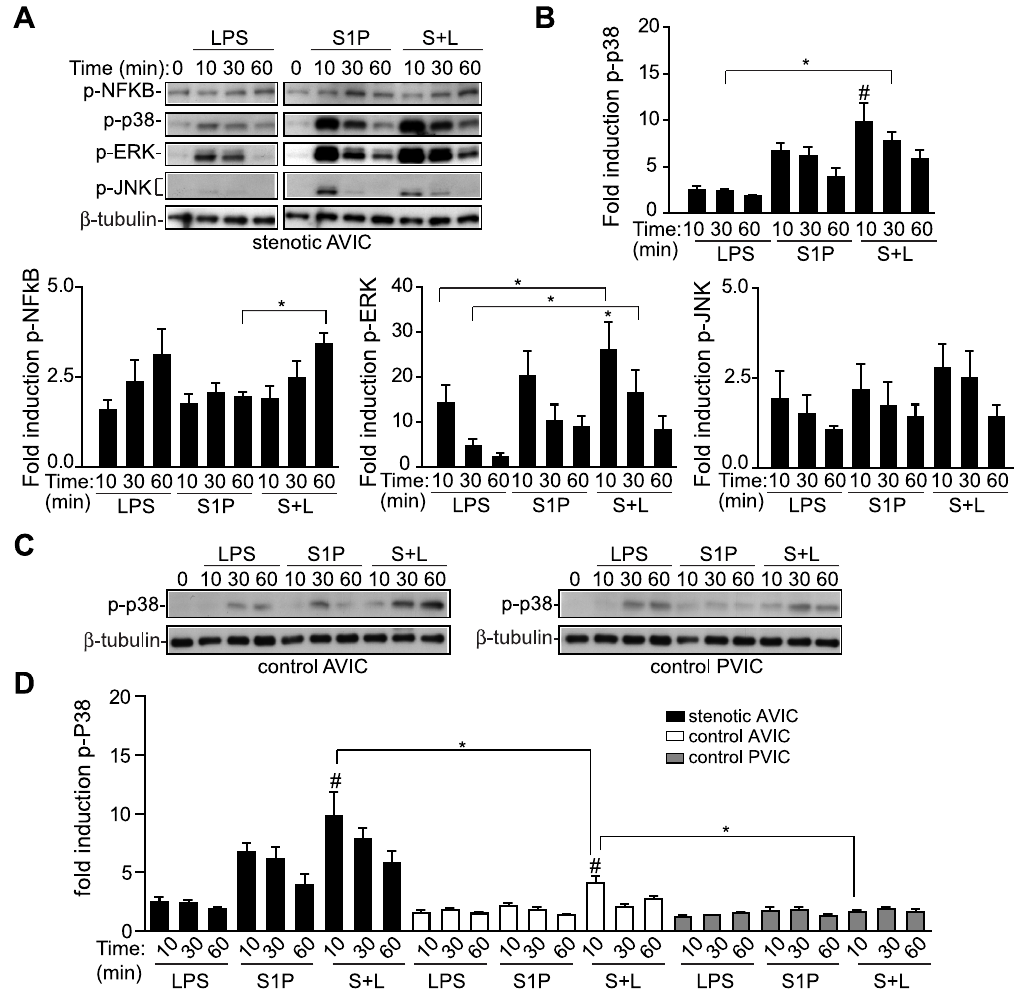
Figure 5. Several signaling cascades, mainly p38/MAPK, are involved in the cooperative effect. A–B) Cell lysates from activated stenotic AVIC were analyzed for the early phosphorylation of NF- k B and MAP kinases. Representative immunoblots and densitometry data show synergistic activation of p38 by S1P + LPS (n=6). Sample at t=0 was run in both gels for comparison purposes. C) Representative immunoblots of p38 phosphorylation in AVIC and PVIC from the same patient processed in parallel are shown. D) Densitometry data is expressed as the fold induction of p-p38 relative to resting values (t=0) using data previously normalized to the reference gene, b -tubulin (mean 6 SEM, n=5–7). Color bars, as in Figure 2. * p , 0.05; # p , 0.05 for S1P + LPS vs. LPS and S1P (at the same time